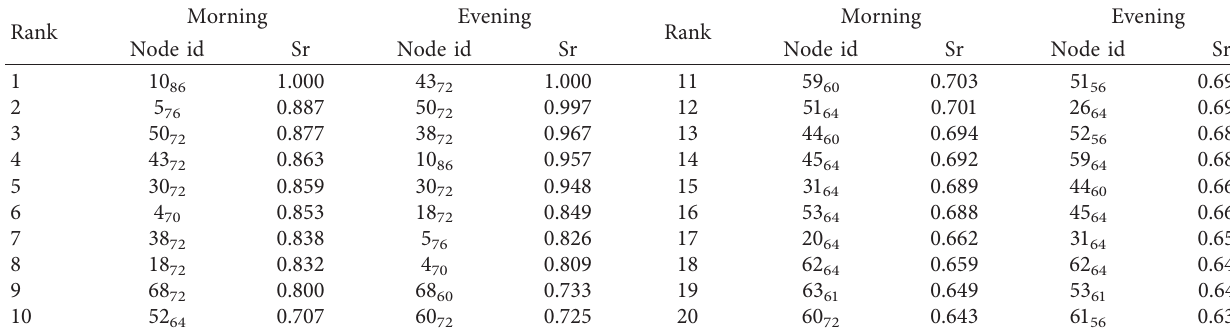
Figure 13: Identification results of key nodes in peak hours on Saturday. (a) 9:00–11:00. (b) 17:00–19:00. Table 4: Top 20 key nodes in peak hours on Monday.